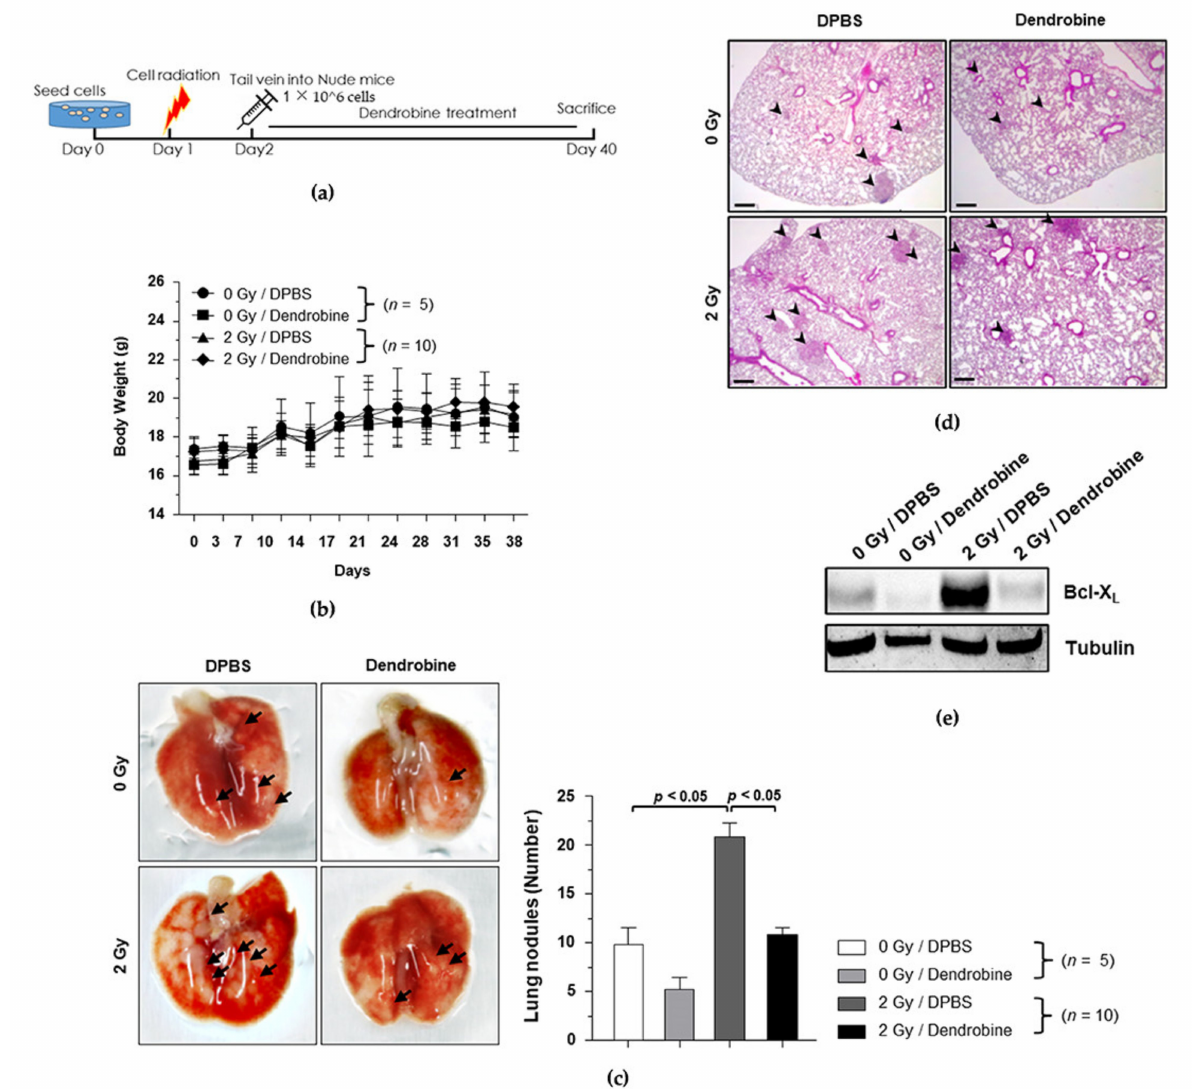
Figure 6. Inhibitory effects of dendrobine on IR-induced metastasis in vivo. ( a ) Schematic diagram of the experimental design for investigating the inhibitory effect of dendrobine on IR-induced metastasis. ( b ) Change in mouse body weights. ( c ) Representative gross lung images. Black arrows indicate metastatic nodules measured for quantitative analysis. ( d ) H&E staining of lung specimens. ( e ) Bcl-X L protein levels in lung tissues were compared using Western